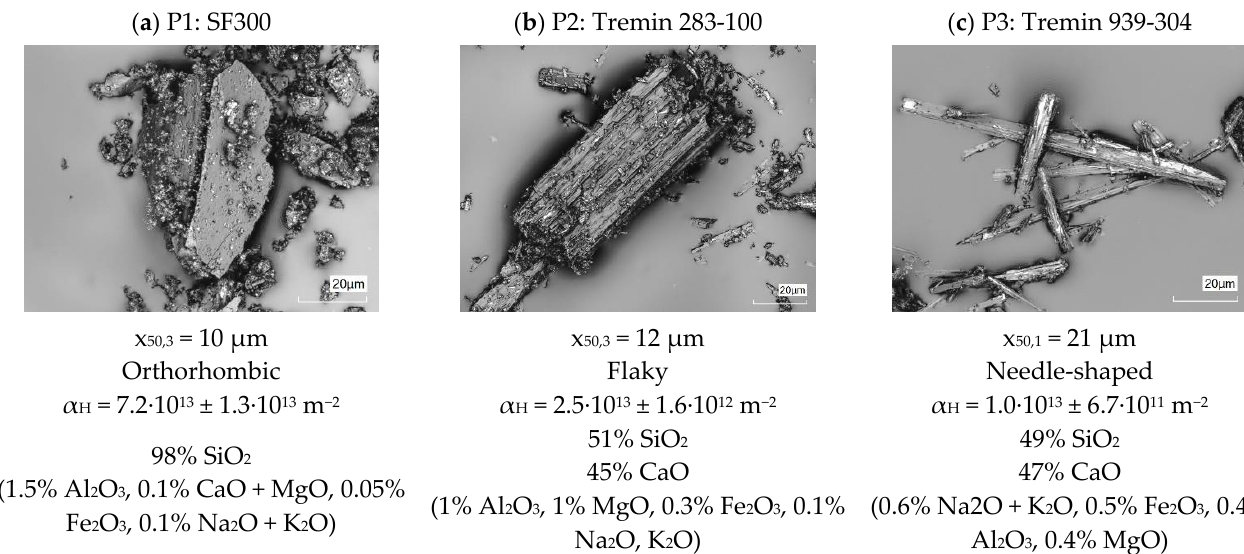
Figure 4. ( a – c ) Microscopic image of the investigated particle systems with orthorhombic (P1), flaky (P2) and needle-shaped (P3) particle shape.